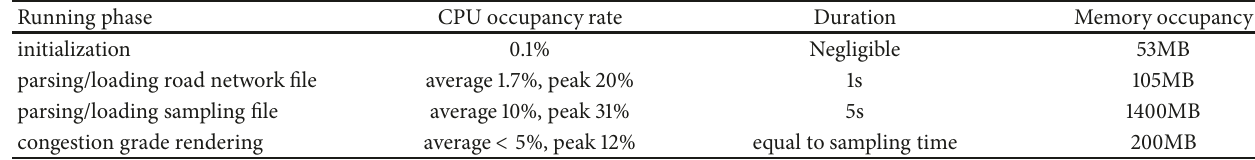
Table 11: Monitoring table of occupying Resources of Karamay Network Operation Program.